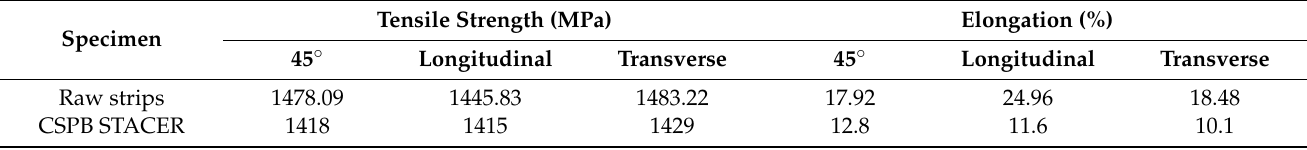
Figure 5. The stress–strain curves of ( a ) raw strips and ( b ) CSPB STACER. Table 2. Tensile strength and elongation of raw strips and CSPB STACER.